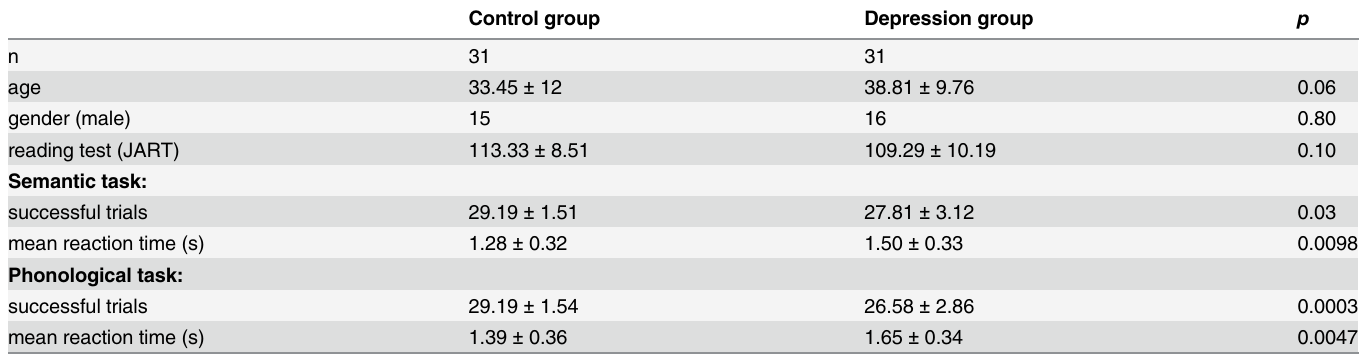
Table 1. Study participants and behavioral performance (mean ±